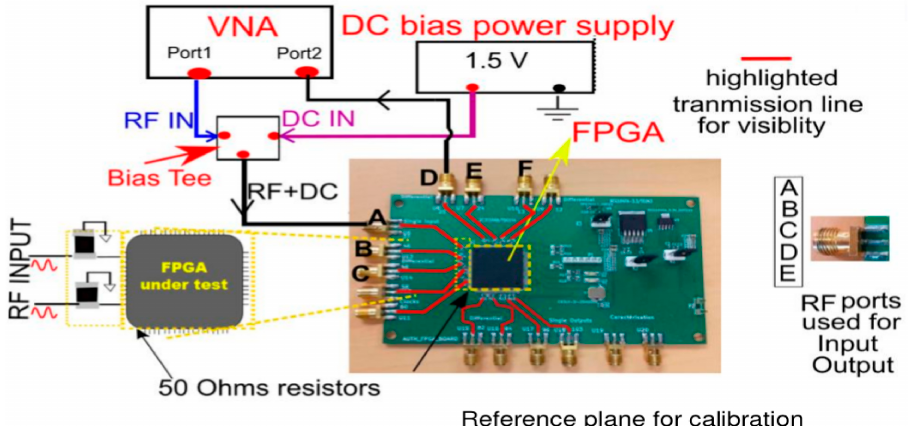
Figure 4. Measurement setup on the customized FPGA PCB to perform the RF test. Inset zoom shows an enlarge description of 50 Ohms resistors used with the transmission for proper matching. Input- Output (IO) ports naming is described which is used throughout this study. The reference plane for the calibration is also shown. VNA = vector network analyzer.